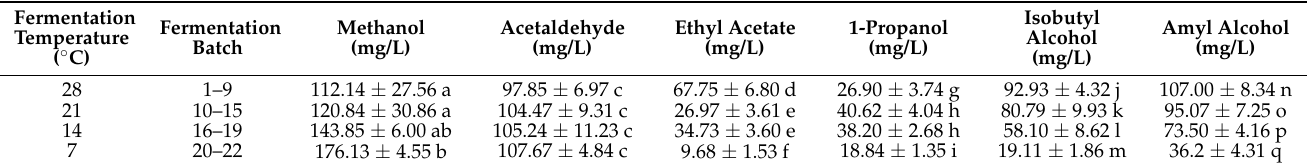
Table 4. Major volatile by-products of must repeated fermentation batches (12.5 ◦ Be) using free cells at 28, 21, 14 and 7 ◦